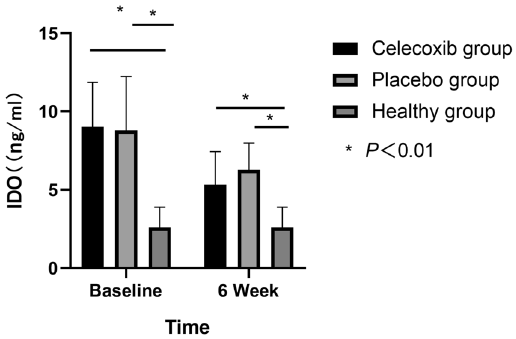
Fig. 2 Treatment outcome of IDO for celecoxib and placebo groups. IDO: indoleamine 2, 3-dioxygenase enzyme; celecoxib group: schizophrenia patients were treated with celecoxib combina- tion with risperidone; placebo group: schizophrenia patients were treated with placebo combination with risperidone.